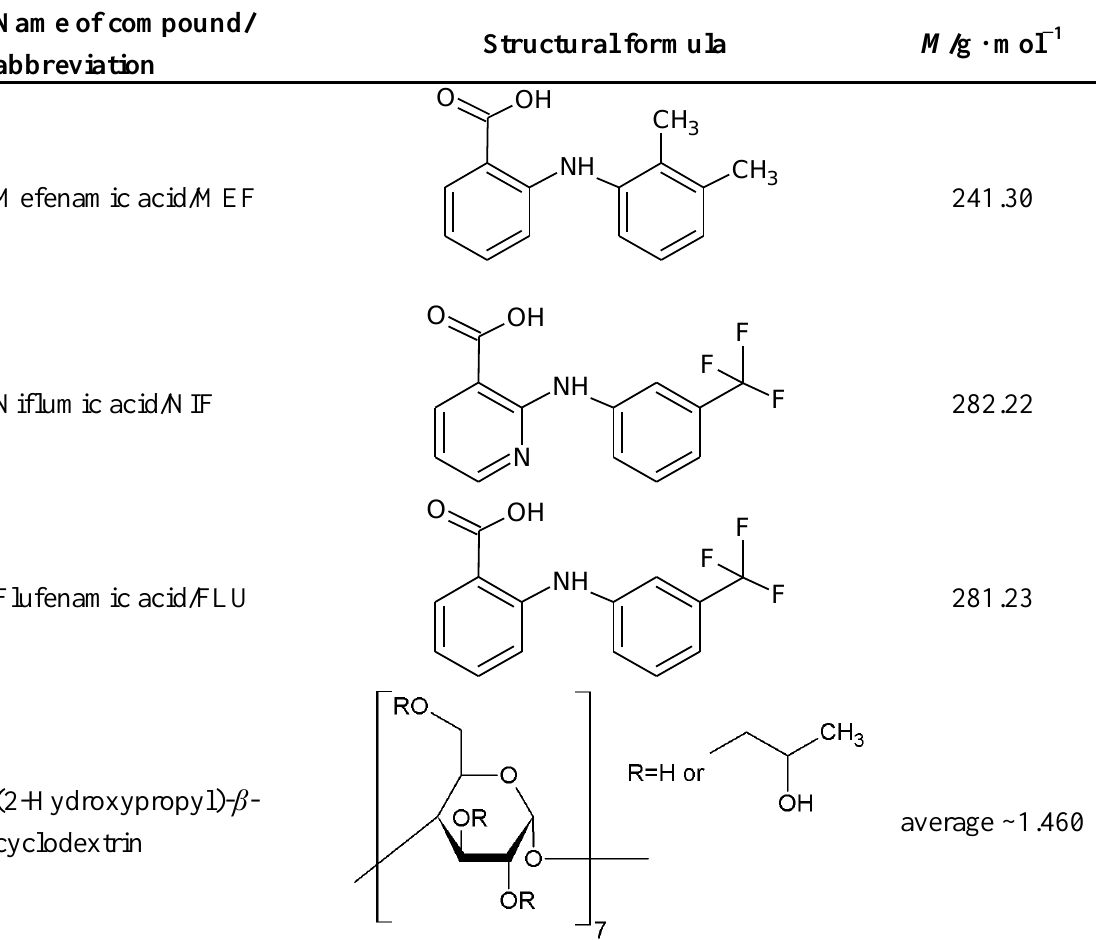
Table 3. Investigated compounds: name, abbreviation, structure, and molar